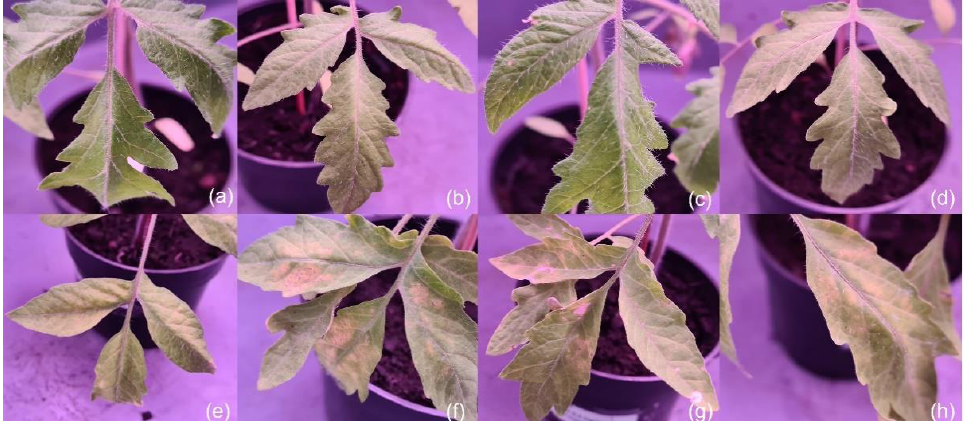
Figure 3. Disease symptom monitoring, 12 days after infection (10 days after treatments). ( a ) Uninfected + Untreated (CBC, negative control); ( b ) Uninfected + EO (CBS); ( c ) Uninfected + EO-zein NPs (CBSZ); ( d ) Uninfected + Zein NPs (CBZ); ( e ) Infected + Untreated (CBX, positive control); ( f ) Infected + EO (CBXS); ( g )-Infected + EO-zein NPs (CBXSZ); ( h ) Infected + Zein NPs